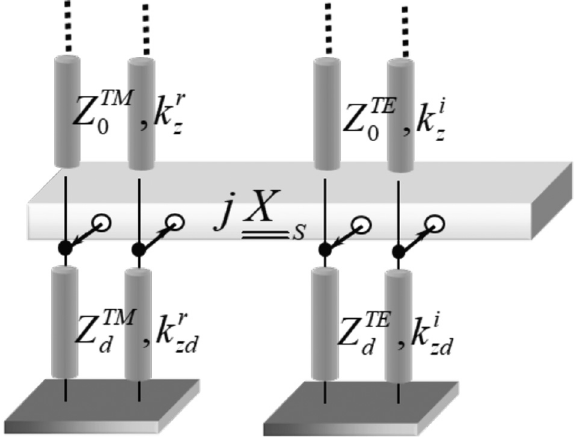
Fig. 3. Equivalent transmission line network for a TE-polarized incident wave and a TM-polarized re fl